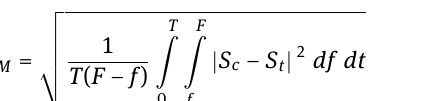
over the duration of the event, T , and the frequency range of interest, F − f